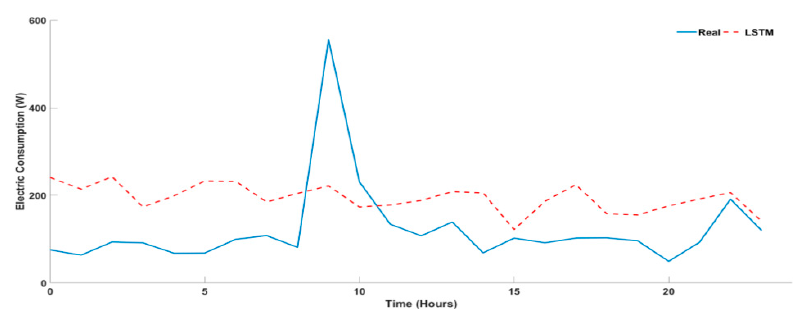
Figure 10. LSTM for 24-h ahead forecasting .